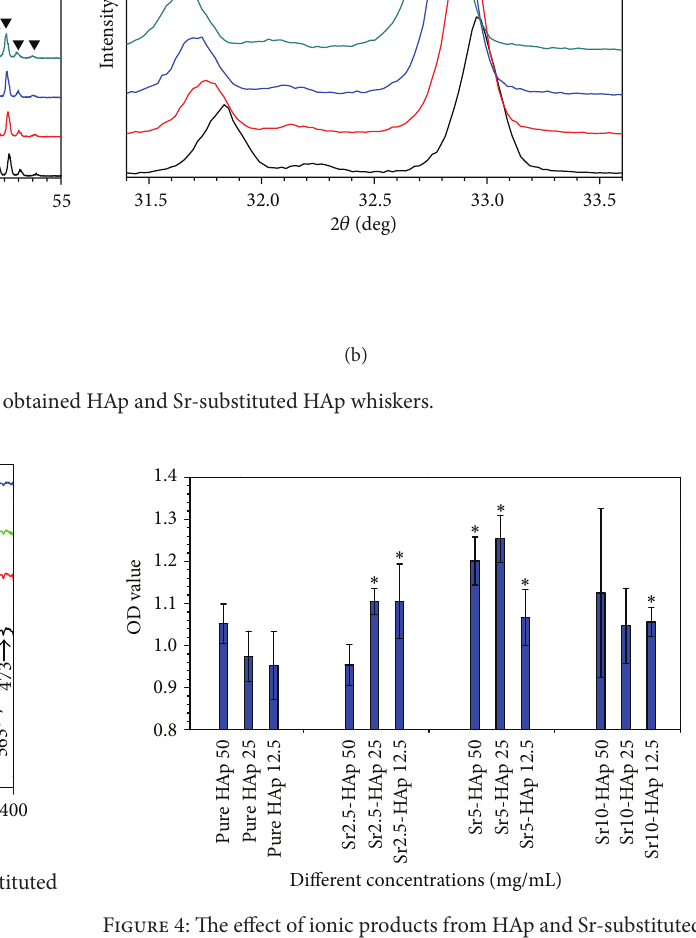
Figure 4: The effect of ionic products from HAp and Sr-substituted HAp whiskers on proliferation of MG-63 after 5 days of culture. ∗ indicates the experimental group compared with the control group of HAp whiskers at the same concentration, ∗ 𝑃 < 0.05